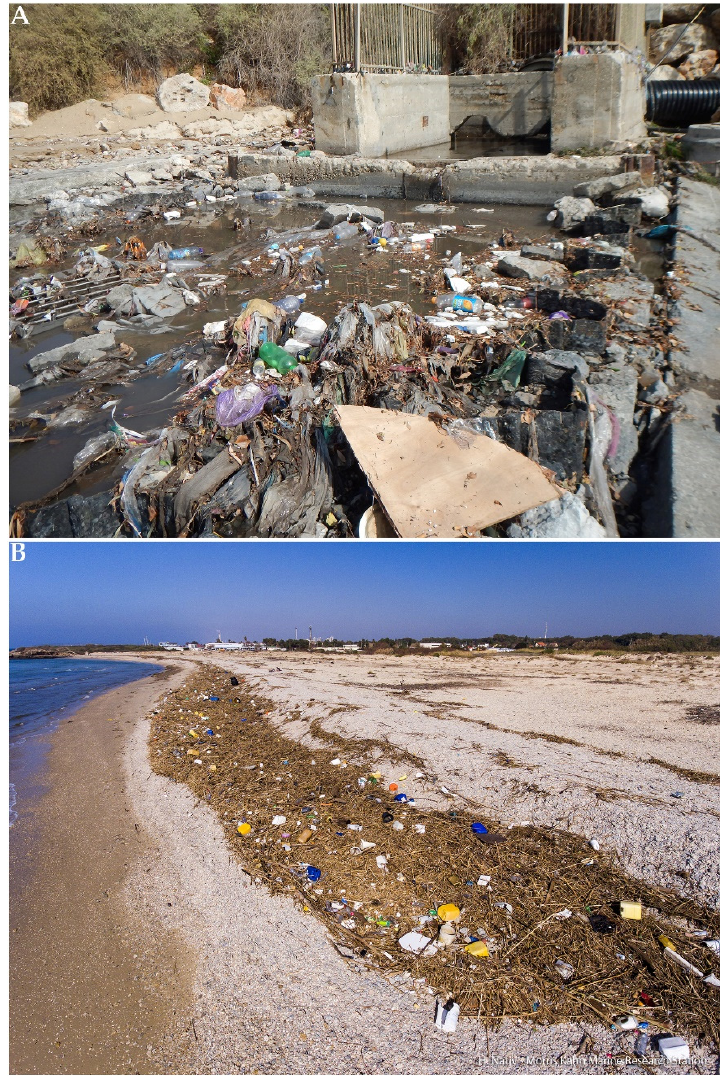
Figure 16. Solid waste beach outfall of the municipal drainage system of Netanya after the first rainstorm following the rainless Israeli summer (( A ), photograph by Galia Pasternak); organic and plastic debris swept to shore after a storm (( B ), photograph by Hagai Nativ).